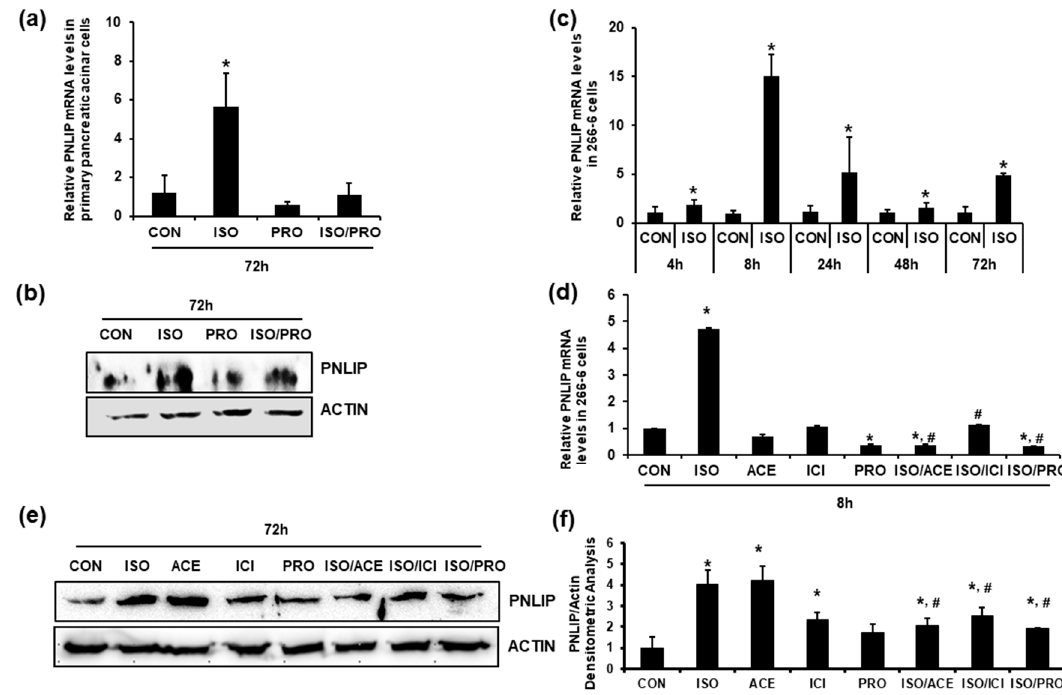
Figure 2. Isoproterenol induced the expression of PNLIP in the pancreatic acinar cells, which was blocked by β 1- or β 2-adrenergic receptor antagonists. The primary cultured mouse pancreatic acinar cells ( a , b ) and the 266-6 pancreatic acinar cell line ( c – f ) were incubated with the indicated reagents and PNLIP expression levels were examined using quantitative RT-PCR ( a , c , d ) and western blotting and densitometric analyses ( b , e , f ). The quantitative data are presented as the means ± S.D. of triplicates (* p < 0.05 vs. CON, # p < 0.05 vs. ISO). ISO, 1 μ M isoproterenol; PRO, 10 μ M propranolol; ACE, 10 nM acebutolol; ICI, 10 nM ICI-118551.